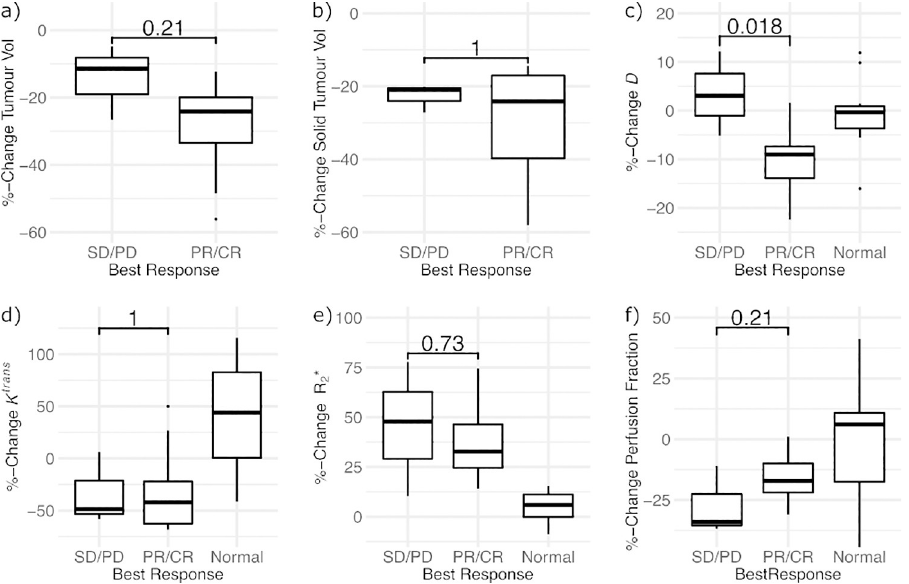
Fig 3. Treatment related changes: Percentage change in the whole tumour volume (a), solid tumour volume (b), solid tumour Diffusivity D (c), solid tumour K trans (d), solid tumour R 2 � (e) and solid tumour perfusion fraction (f) between patients with stable/progressive disease (SD/PD) and partial/complete response (PR/CR). P-values for Mann-Whitney U test. Relative changes in normal renal tissue illustrate the test re-test variability in imaging measurements